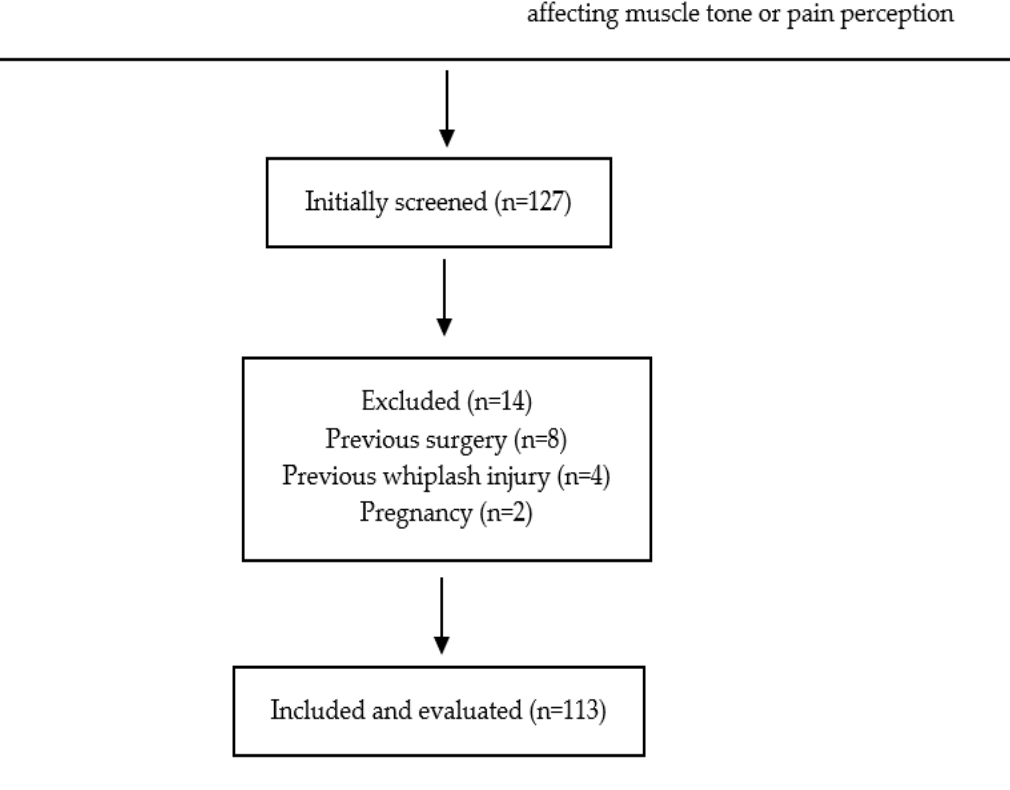
Figure 1. Flow diagram of patient recruitment.